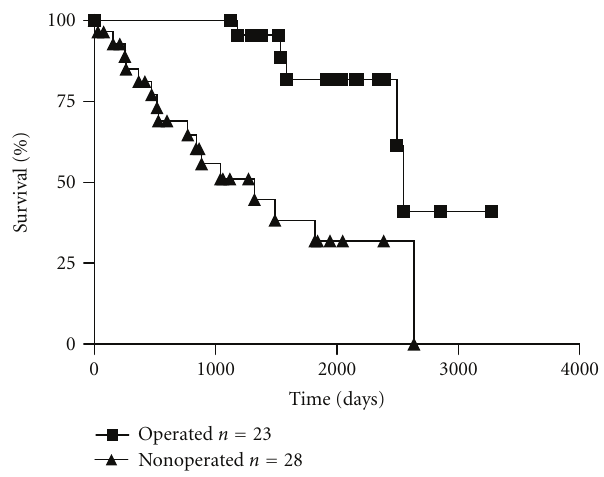
Figure 1: Survival in the study group (endocrine therapy (ET) alone) and in the control group (ET plus surgery), log-rank test: P = 0 .